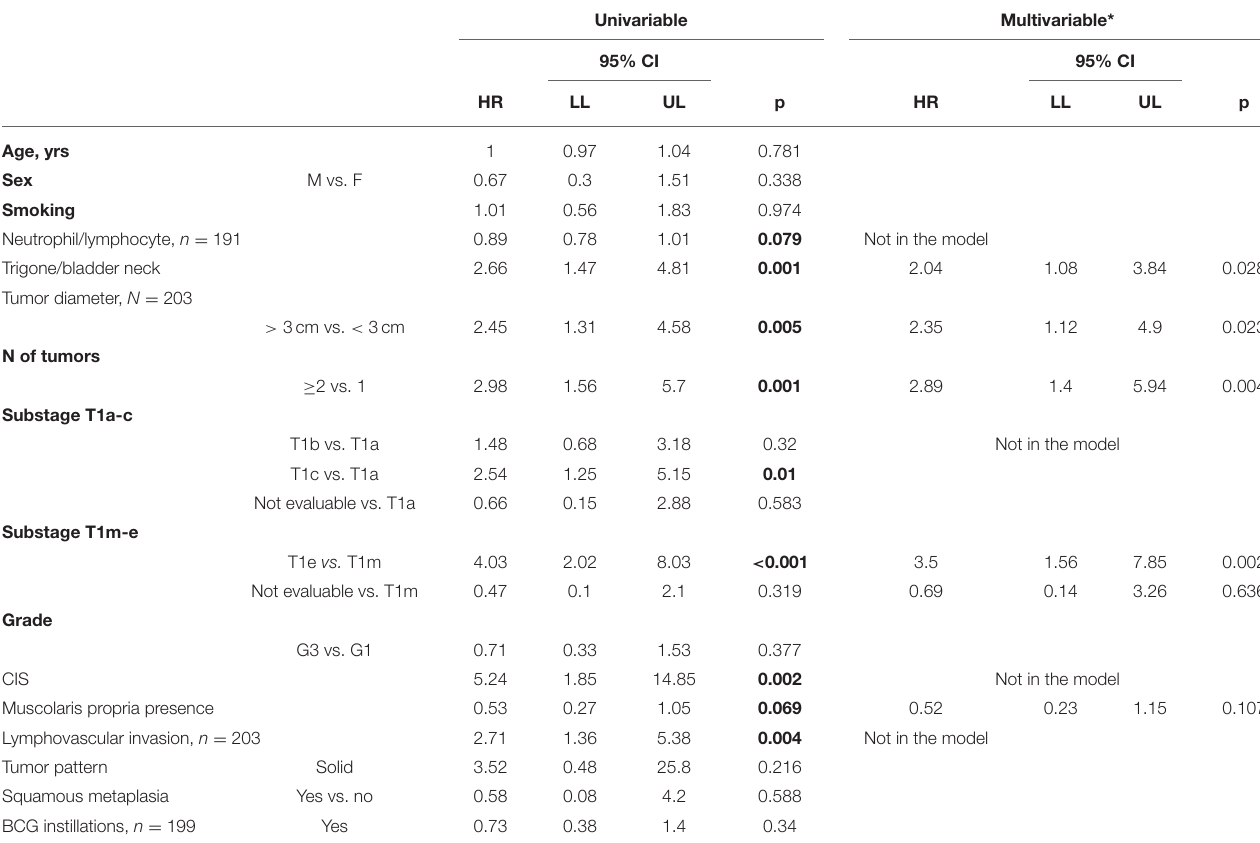
TABLE 7 | Uni and multivariable Cox regression model was performed to evaluate which independent variables influence the